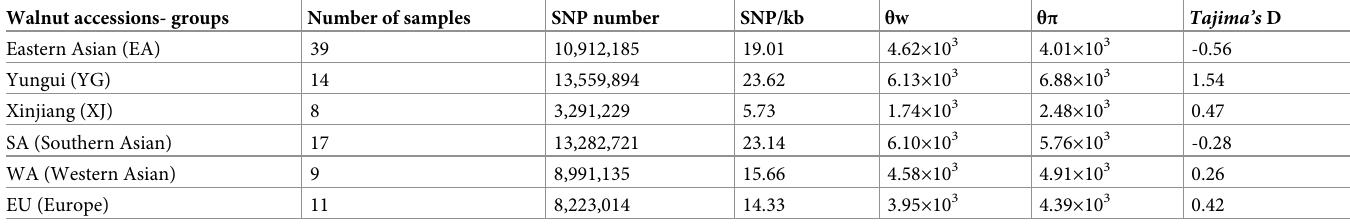
Table 2. Genetic diversity and Tajima’s D in wild Persian walnuts. Walnut accessions-